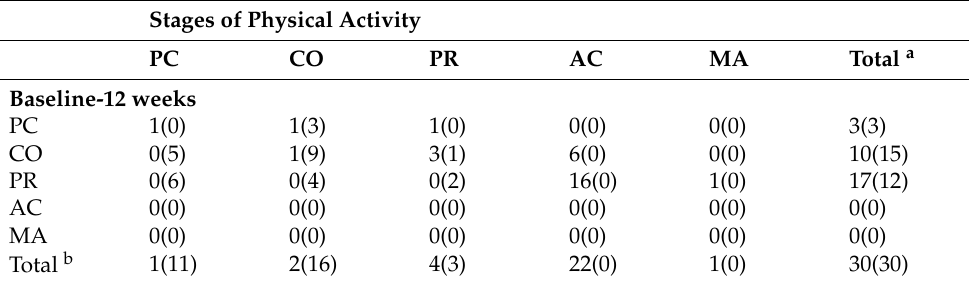
Table 3. Changes in the stage distributions of physical activity over the intervention.